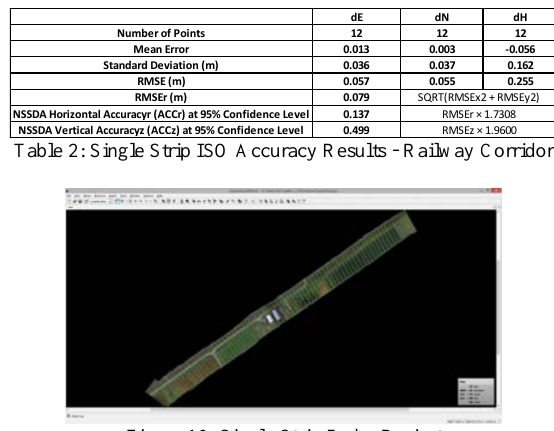
Figure 10: Single Strip Inpho